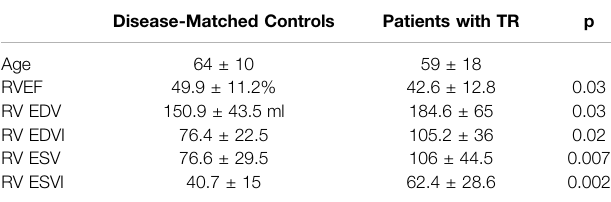
TABLE1| PatientCharacteristics.RV=Rightventricle.EF=ejectionfraction.EDV = End-Diastolic Volume, EDVI = End-Diastolic Volume Indexed to